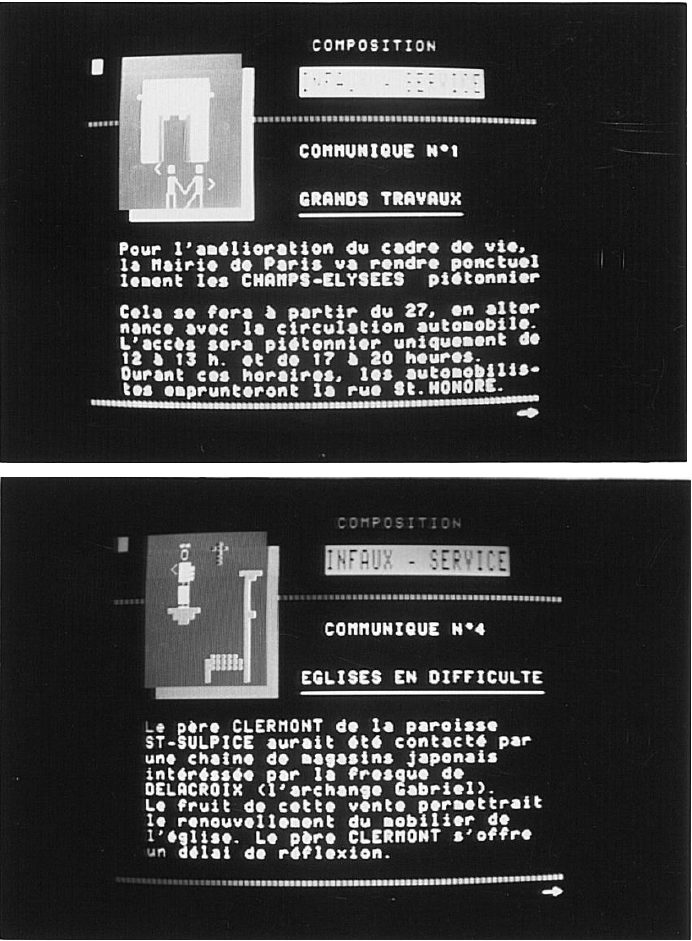
Figure 6. Images from “Infaux Service”, project by the artist Alain Snyers for Art Accès . Collection Frédéric Develay © Kandinsky Library, MNAM/CCI, Centre Pompidou.